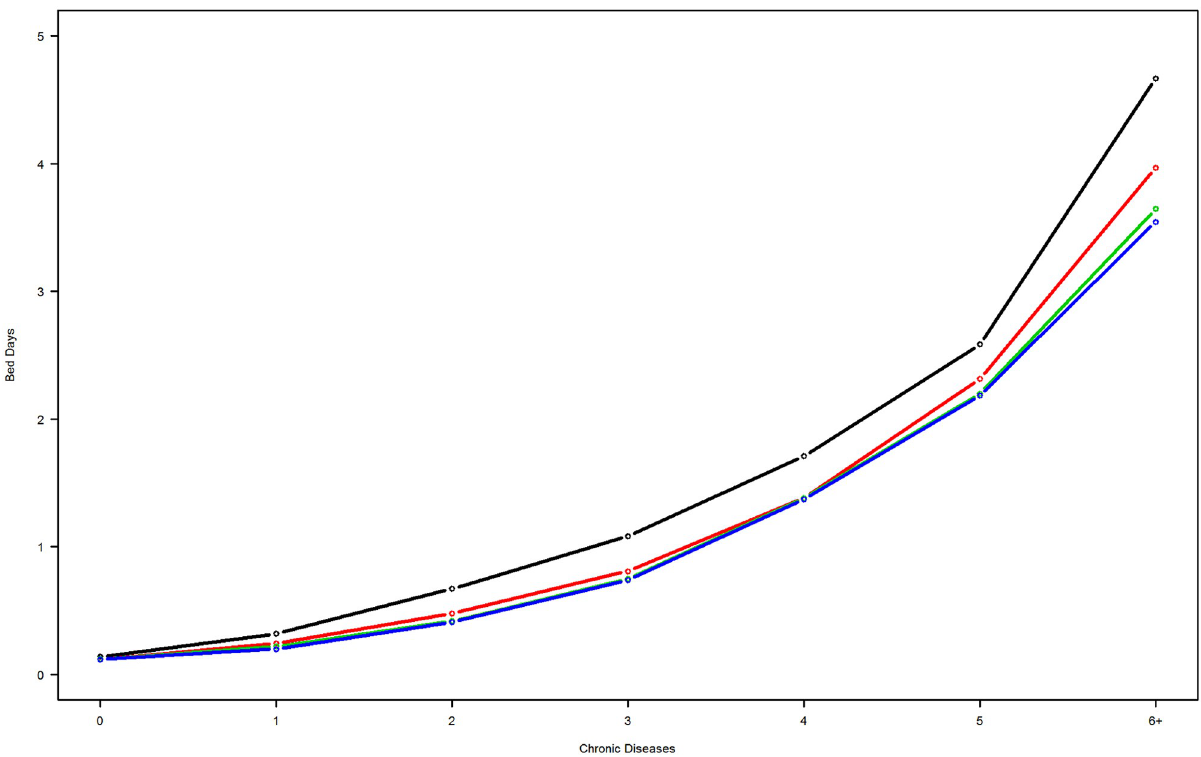
Fig 3. Number of chronic conditions associated with the modeled rate of bed days by educational attainment. Black line, no education; red line, short education; green line, medium education; blue line, long education.